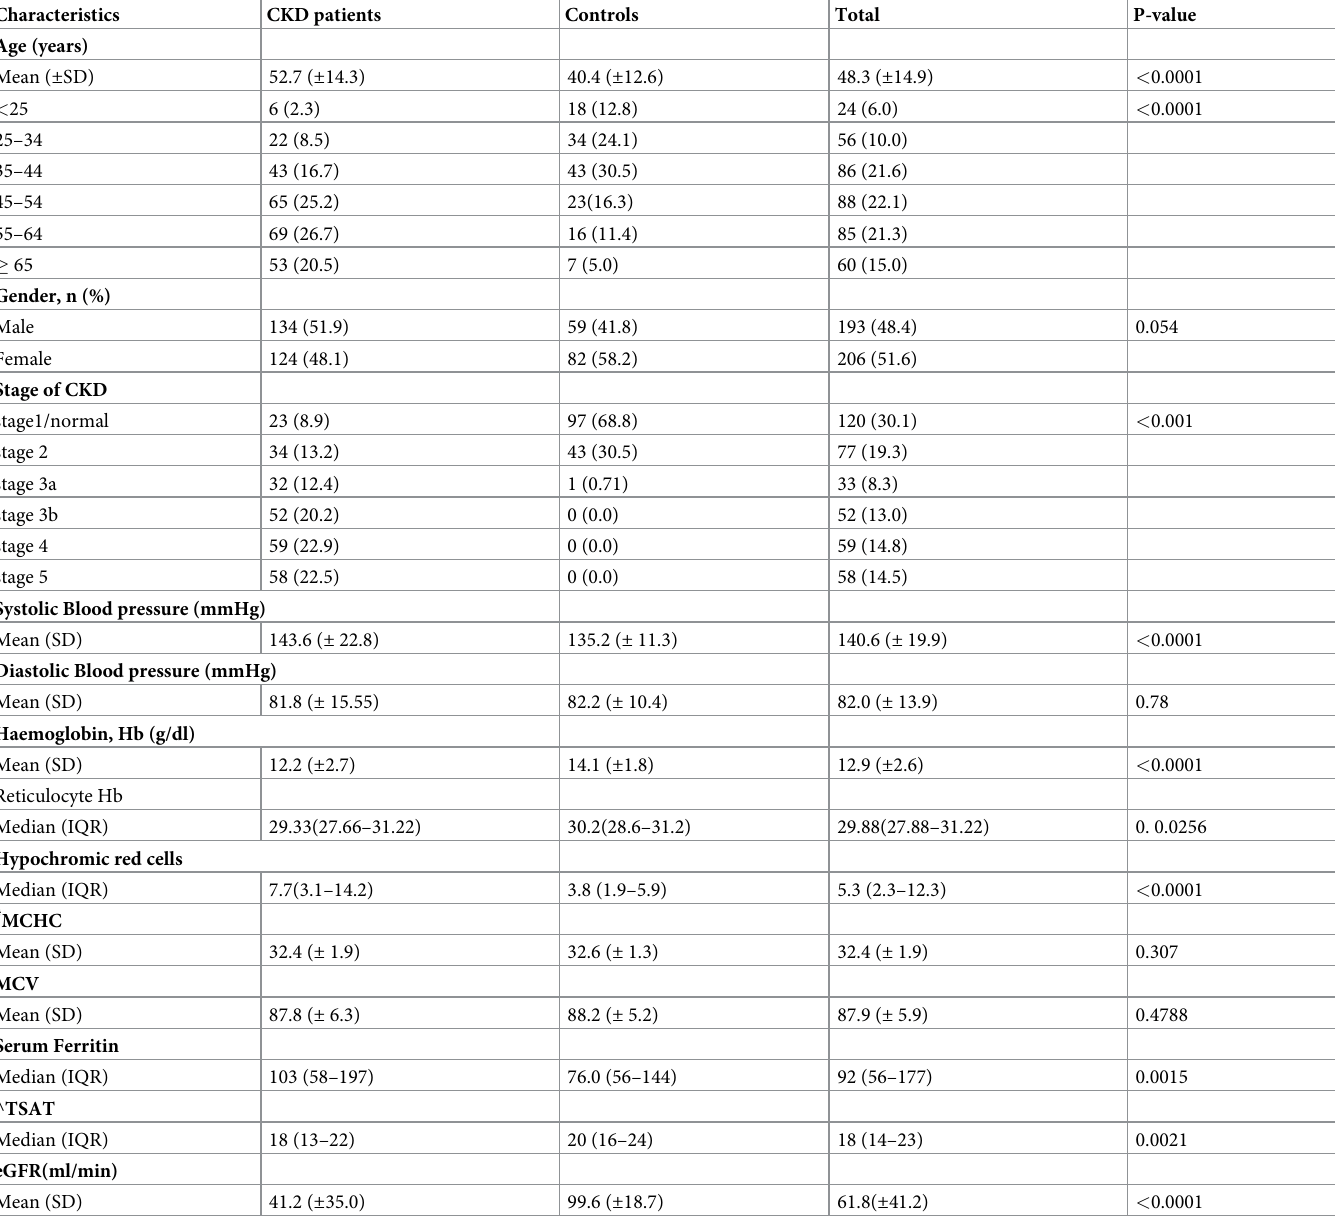
Table 1. Comparison of the socio-demographic, haematological and biochemical characteristics of CKD patients and controls.